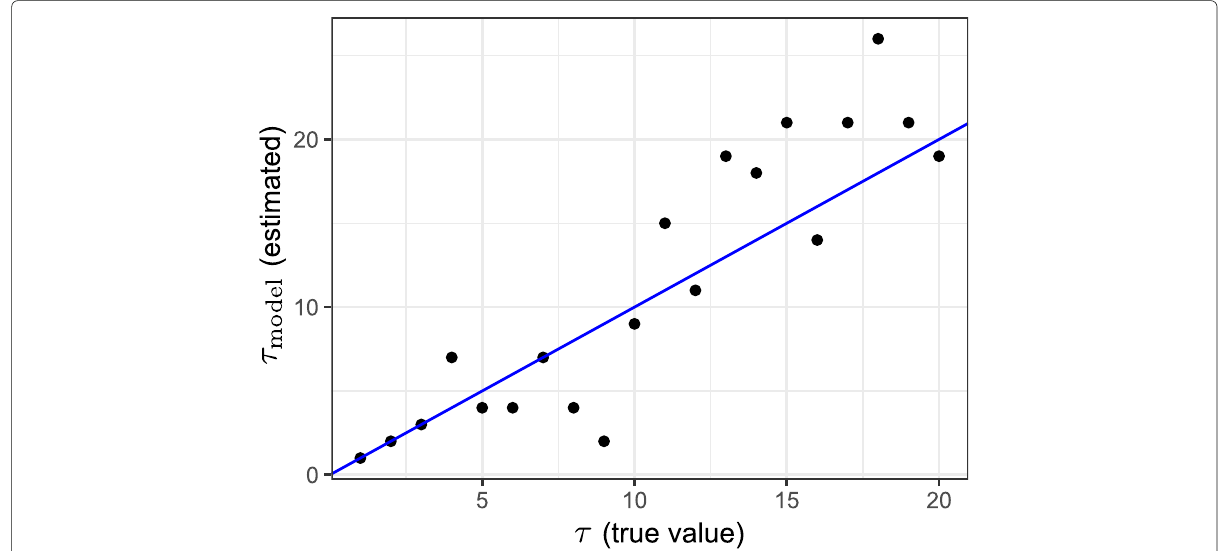
Fig. 4 Estimates τ model for synthesized crash data with different true values for τ . The diagonal τ model = τ has been added as a